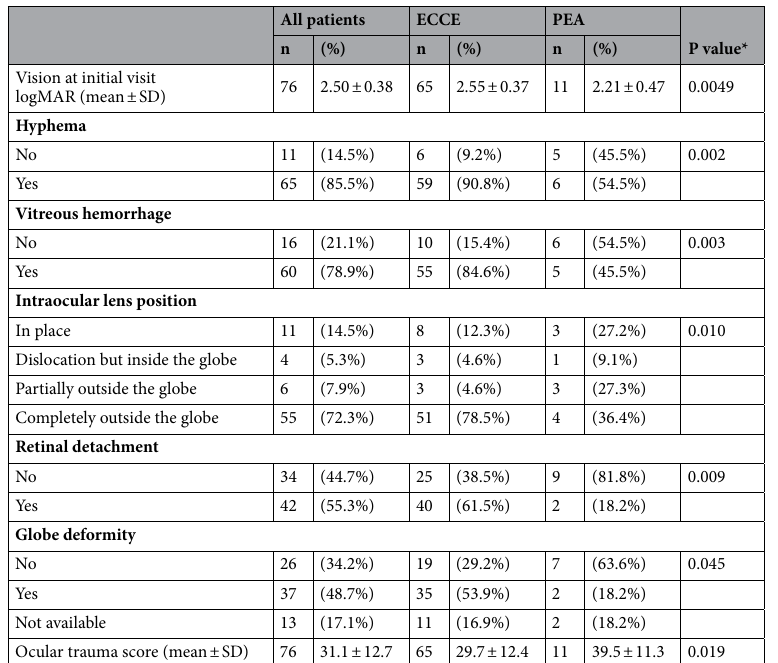
Table 3. Clinical presentation at the initial visit after traumatic cataract wound dehiscence in patients with prior extracapsular cataract extraction and phacoemulsification (all 76 eyes are included). ECCE extracapsular cataract extraction, PEA phacoemulsification, logMAR log of minimal angle of resolution. *P value of statistical test between ECCE and PEA.